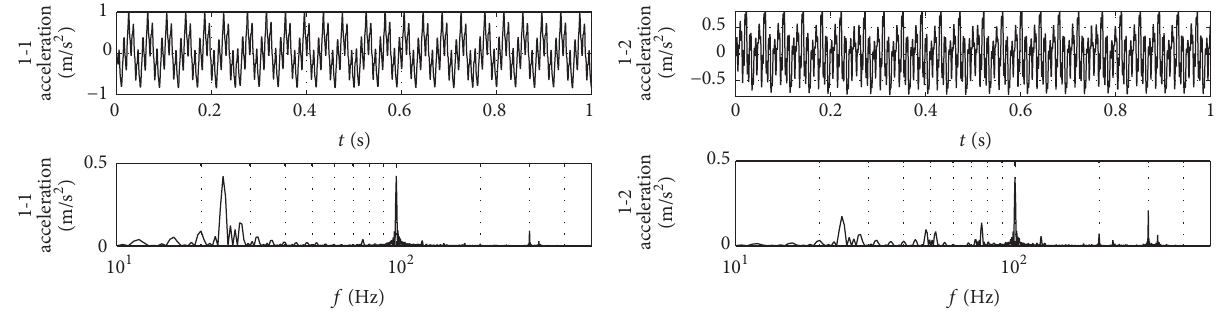
(b) Time-frequency domain curves of the acceleration signal in 6-5 motor position Figure 21: Actual vibration acceleration signals of two excitation motors.